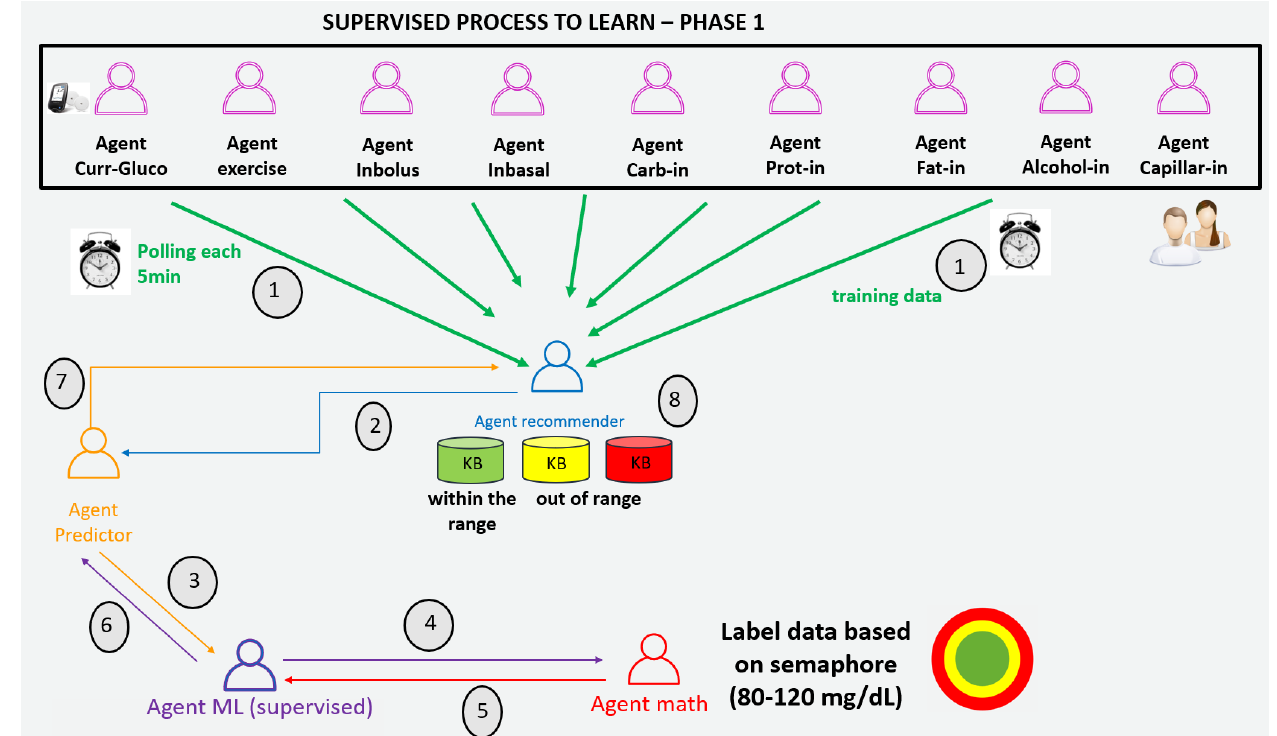
Figure 4. Tesseratus set up: acquiring